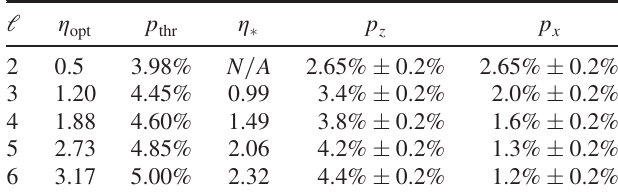
TABLE III. Thresholds for the union-find decoder in the phenomenological model. Simulations were done on lattices of size 35 × 35 × 35 at